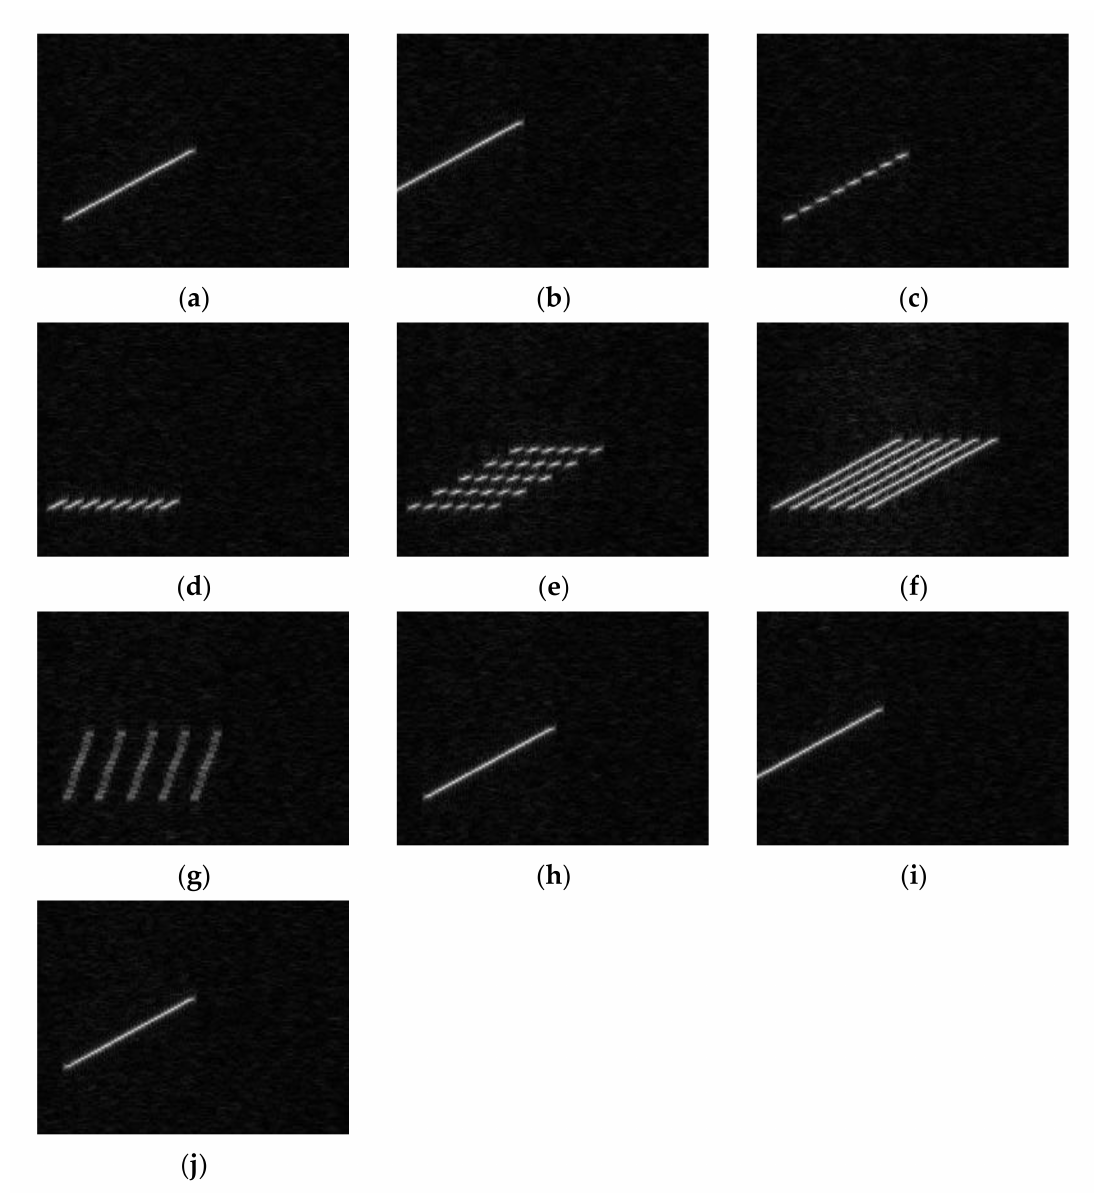
Figure 4. Time–frequency diagram of jamming signals. ( a ) RFTJ. ( b ) VFTJ. ( c ) ISDJ. ( d ) PDTJ. ( e ) ISRJ. ( f ) WDTJ. ( g ) SMSP. ( h ) RGPO. ( i ) VGPO. ( j )